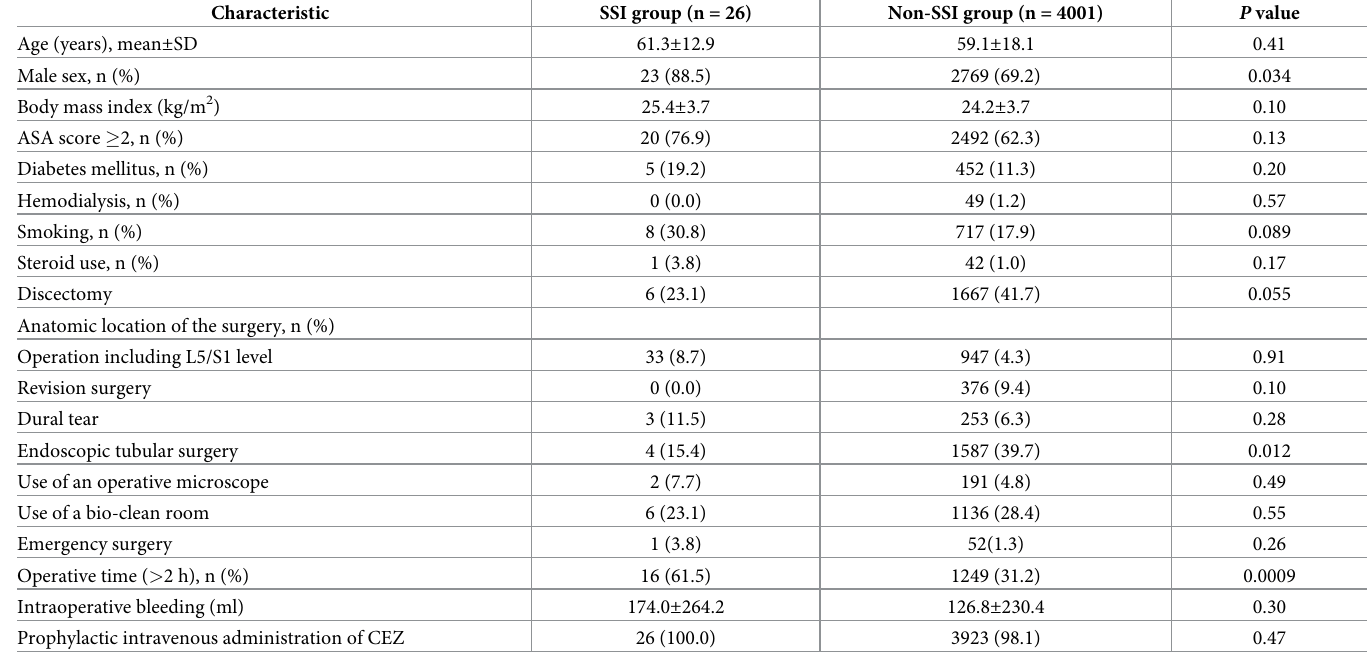
Table 1. Demographic characteristics of the SSI and Non-SSI